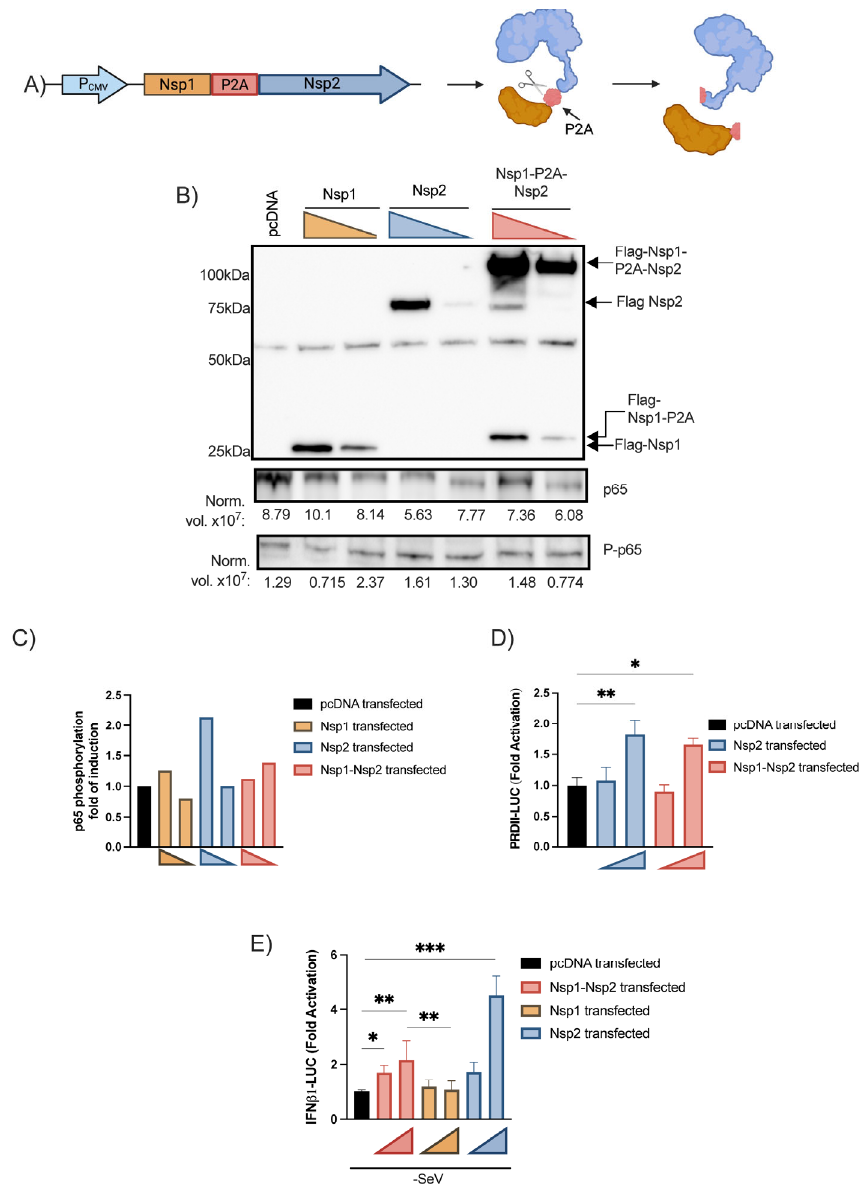
Figure 6. Effects of Nsp1-Nsp2 polyprotein on IFN β and ISRE-luc promoter activation and p65 subunit phosphorylation. Schematic representation of the Nsp1-P2A-Nsp2 encoding vector cleaved products ( A ). Nsp1 and Nsp2 coexpression and p65 expression following polyprotein vector trans- fection ( B ) and the relative p65 phosphorylation ( C ). HEK293T were seeded in 6-well plate. Twenty- four hours after, cells were transfected with 0.4 pmol or 0.2 pmol of Nsp1 expression vector, Nsp2 expression or Nsp1-Nsp2 polyprotein vector. Forty-eight hours post-transfection, cells were lysed with Halt Phosphatase Inhibitor Cocktail and detected by Western Blot with anti-FLAG (viral pro- tein), anti-p65, phospho-NF- κ B-p65-Ser536, and Stain-Free Imaging Technology ® as loading control (Supplementary Figure S2) expressed as normalized levels (Norm. vol. ×10 8 ) below the blot. Then, NF- κ B p65 phosphorylation was normalized with p65 subunit expression and expressed as fold of induction relative to the mock-infected control. This experiment was performed twice, and one rep- resentative experiment is shown. Effects of Nsp1-Nsp2 on PRDII reporter activation, ( D ) IFN β 1 -luc, ( E ). IFN β 1 essay was performed as described above with 20 or 80 fmol of vector encoding for Nsp1, Nsp2 or Nsp1-Nsp2 polyprotein. PRDII reporter essays were performed using 40 or 80 fmol of fol- lowing vectors. All experiments were performed twice in triplicate and the compilation of the data is shown. Results are expressed as fold activation relative to the pcDNA mock-infected control (mean ± SD, n = 6 replicates/condition). The Nsp1-Nsp2 and Nsp1 conditions were compared to the mock control using nonparametric one-way ANOVA with Dunn’s correction. The Nsp1-Nsp2 and